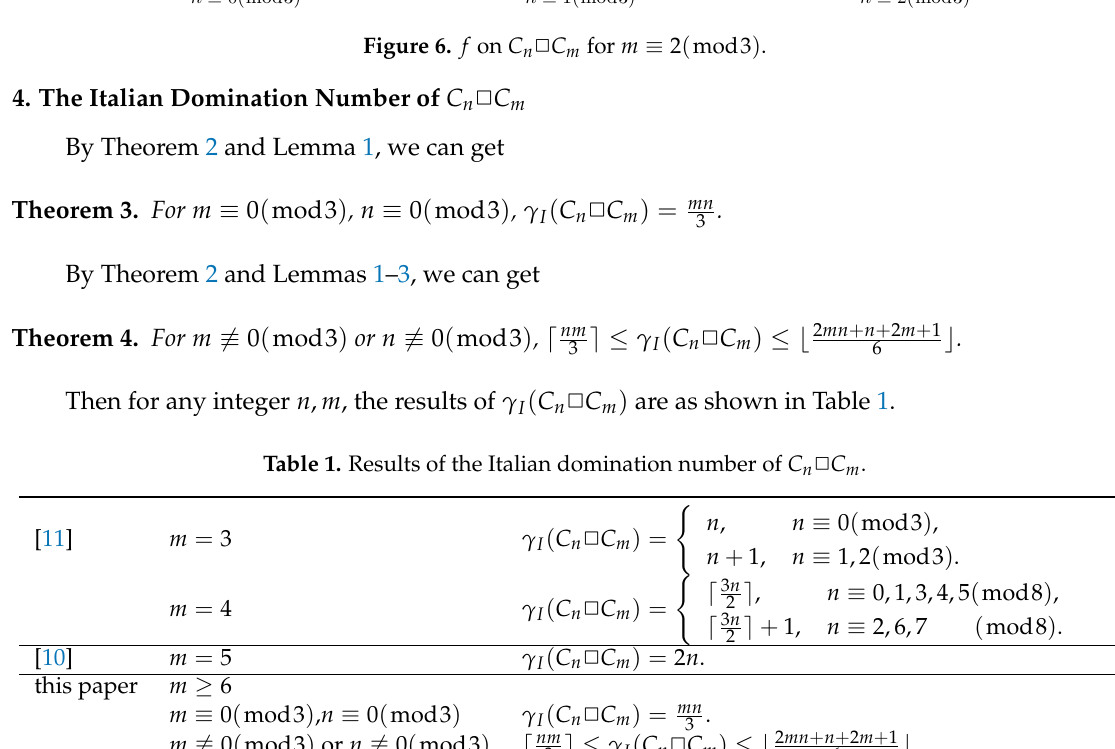
Figure 6. f on C n 2 C m for m